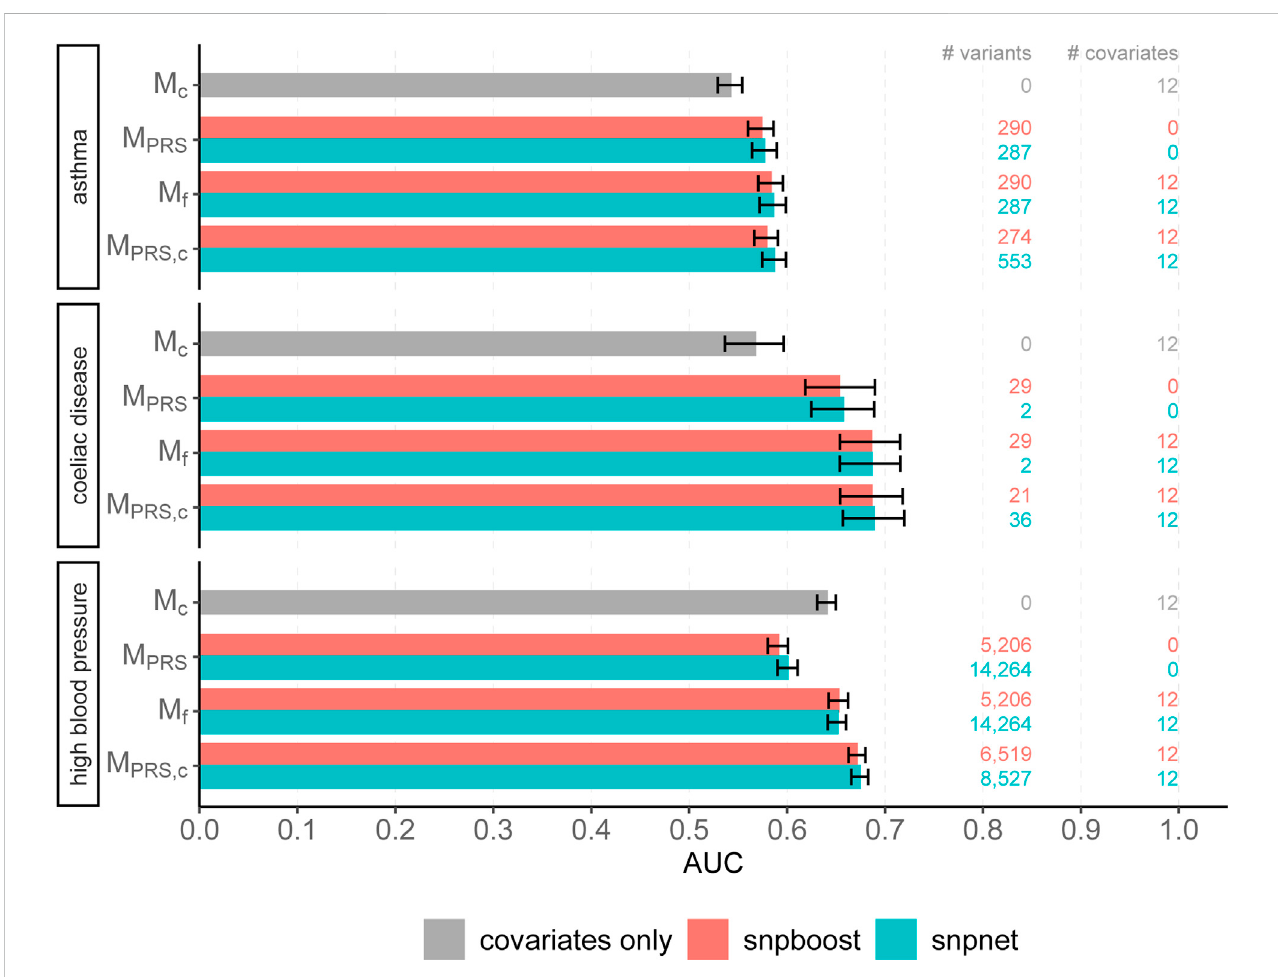
FIGURE 7 Comparison of predictive performance of snpnet and snpboost for three binary phenotypes from the UKBB. Results of the covariate-only model ( M c ; grey bars) and multivariable polygenic models with and without inclusion of the covariates derived by lasso (snpnet; petrol-coloured bars) and statistical boosting (snpboost; red bars) for the prediction of three binary phenotypes from the UKBB. The barplots show the AUC on the test set of 20,164 (asthma), 28,513 (coeliac disease) and 78,741 (high blood pressure) unrelated white British individuals. M PRS corresponds to a logistic regression model incorporating the PRS as a single predictor variable and M f to a logistic regression model incorporating sex, age and the fi rst ten principal components as additionalcovariates. M PRS, c includesthecovariatesalreadyinthe fi ttingprocessofthePRS.Bootstrapped95%con fi denceintervalsareindicatedbyerrorbars. Furthermore, information on the number of selected genetic variants (# variants) and the number of additionally included covariates (# covariates) is